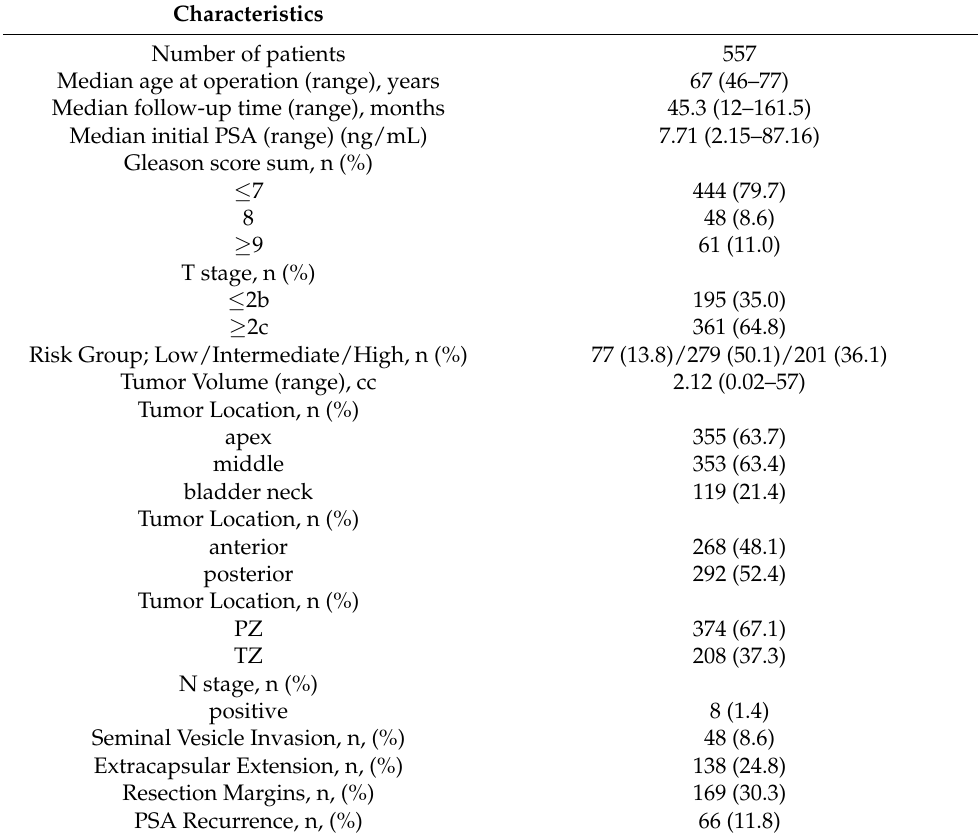
Table 1. Characteristics of